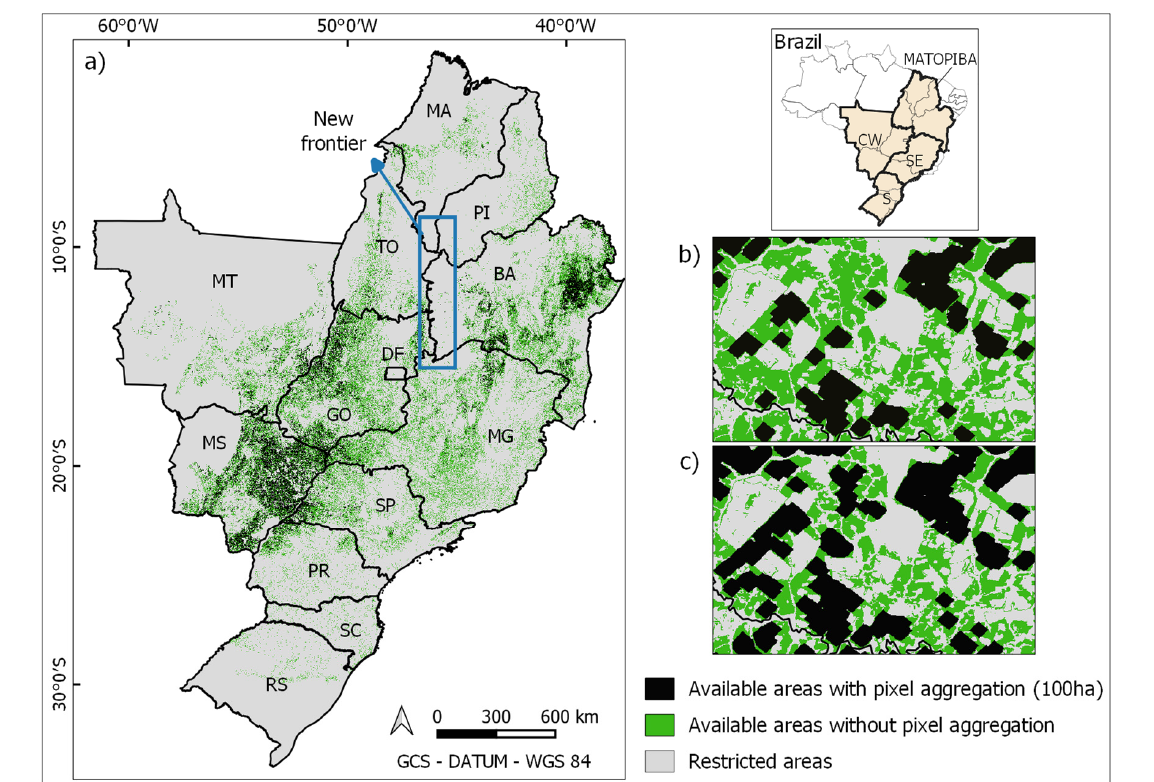
Figure 3. ( a ) Available area for soy cropping expansion with (black) and without (green) pixel aggregation; the current new soy frontier in the 2000s is highlighted. Effects of ( b ) no smoothing and ( c ) after smoothing in the aggregation process.